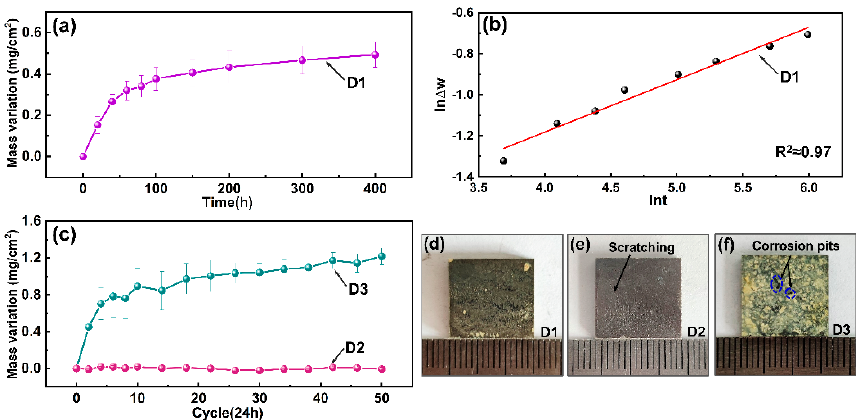
Figure 3. Corrosion kinetic curves and surface macromorphology of test samples: ( a , b ) High temperature oxidation test; ( c ) Salt spray test and alternating high temperature-salt spray test; ( d – f ) Surface macromorphology of samples D1, D2 and D3 .